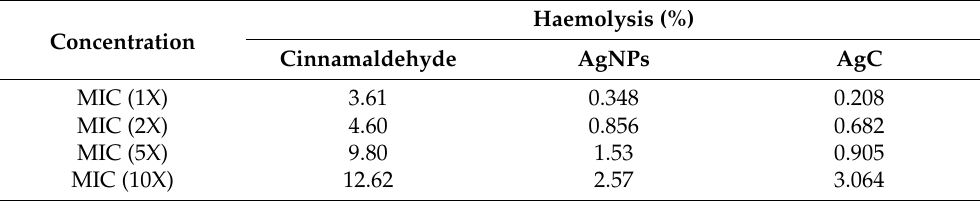
Table 2. In vitro haemolytic assay of cinnamaldehyde, AgNPs and AgC in sheep RBCs. Concentration